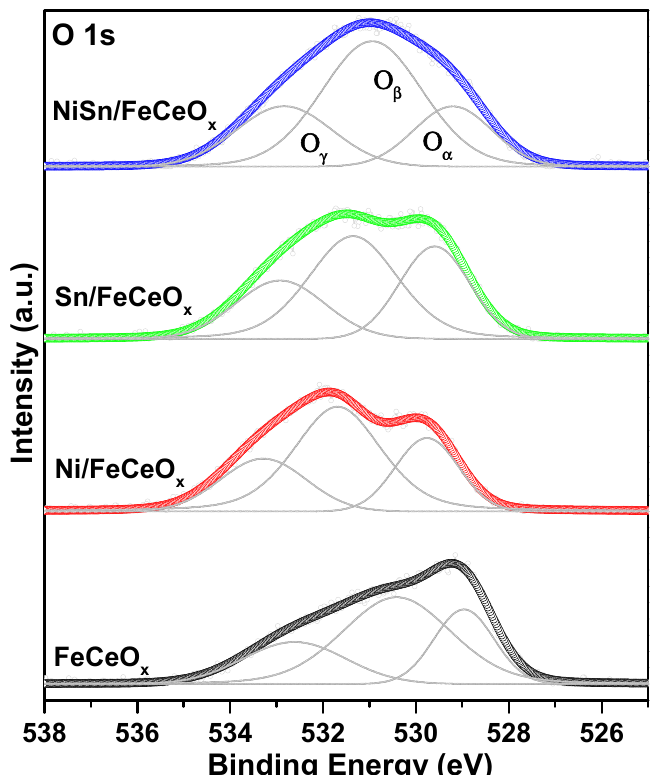
Figure 8. O 1s XPS spectra of reduced FeCeO x , Ni/FeCeO x , Sn/FeCeO x , and NiSn/FeCeO x catalysts. With the loading of Ni and/or Sn on the FeCeO x , the binding energy of O α , O β , and O γ peaks have shifted toward higher regions as compared to the FeCeO x catalyst. This trend in the peaks’ shift can be explained in terms of the electronegativity of elements in the catalysts. The electronegativity of Ni (1.91) and Sn (1.96) is greater than the Fe (1.83) and Ce (1.12), so the electron affinity of Ni and